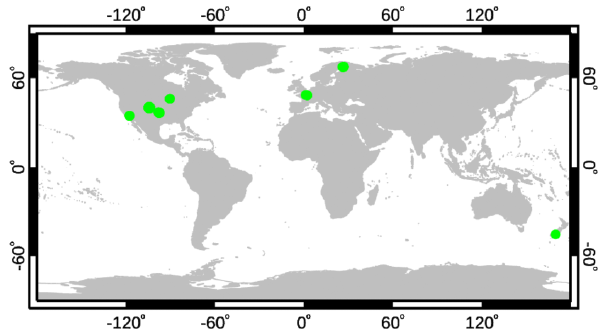
Figure 1. AirCore vertical profile locations listed from west to east. USA: Edwards Air Force Base (California), Boulder (Colorado), Lamont (Oklahoma), and Park Falls (Wisconsin). France: Traînou. Finland: Sodankylä. New Zealand: